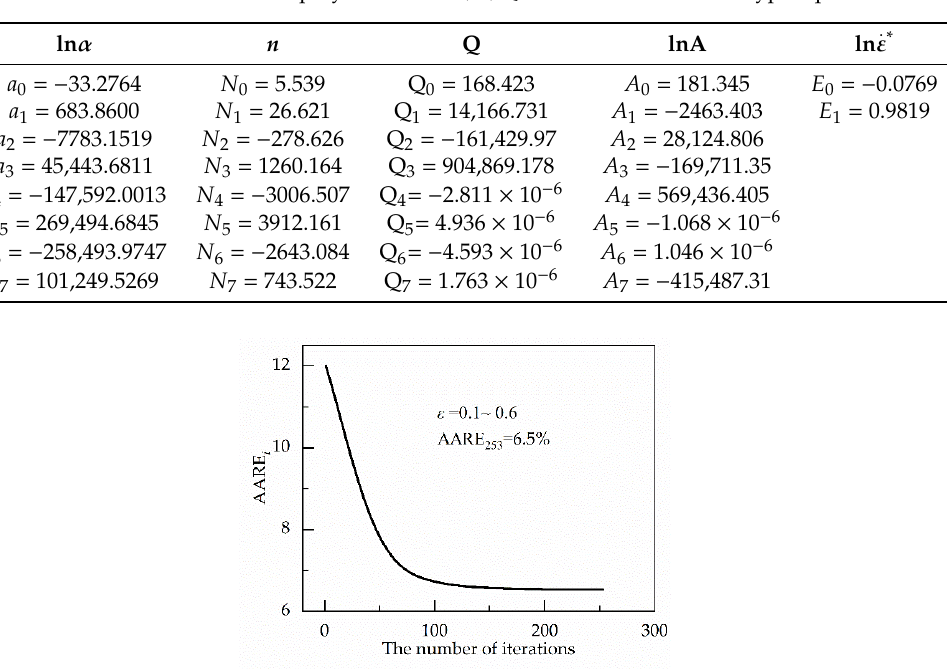
Figure 7. Variation of average absolute relative error (AARE) i with iterations.